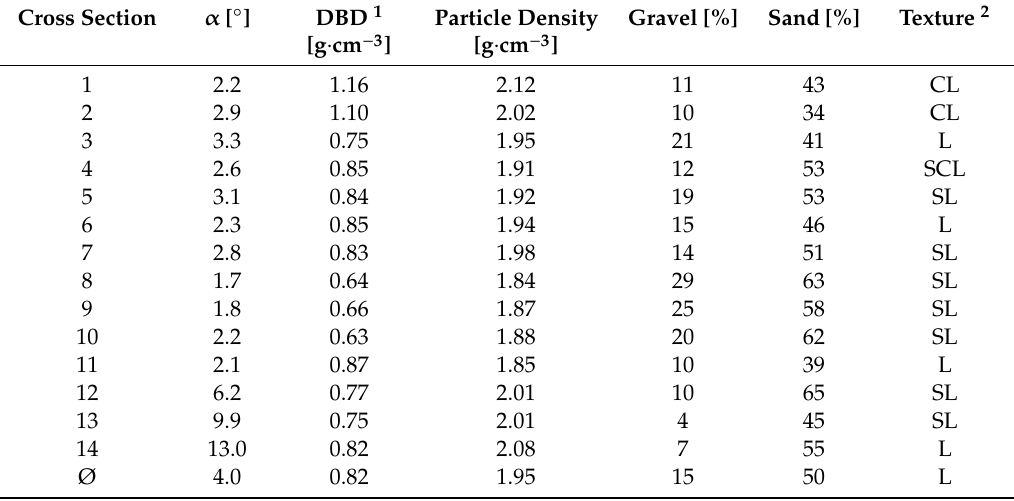
Table 1. Cross section slope ( α ) and mean soil physical properties of undisturbed forest soil. Cross Section α [ ◦ ] DBD 1 Particle Density Gravel [%] Sand [g · cm − 3 ] [g · cm − 3 ]